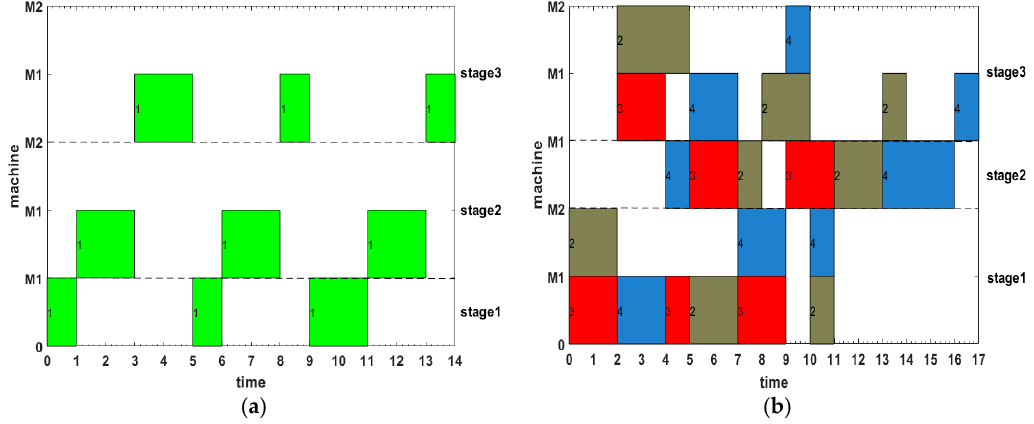
Figure 2. Scheduling Gantt charts of two factories. ( a ) Factory 1. ( b ) Factory 2.